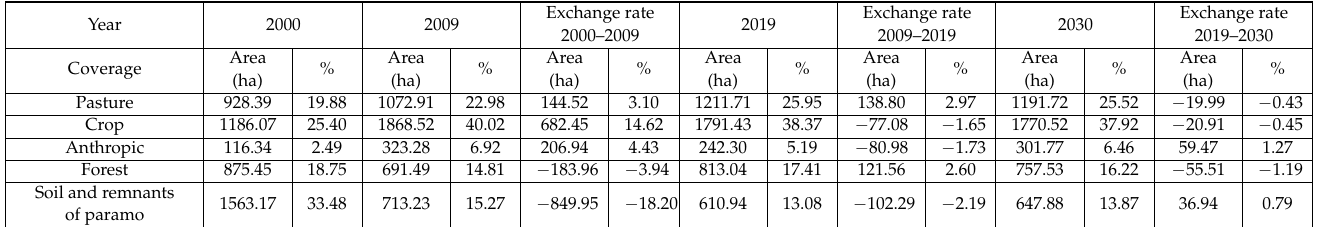
Table 11. Land cover change between the years 2000 and 2019 and its prediction to